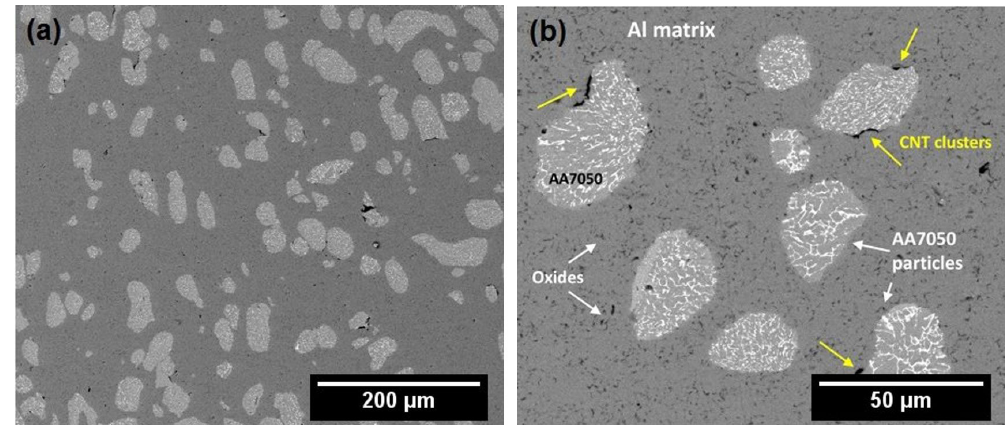
Figure 4. SEM images of composite B as extruded with (a) small and (b) large magnification. White arrows indicate Al oxide in the Al matrix and yellow arrows are MWCNT clusters.